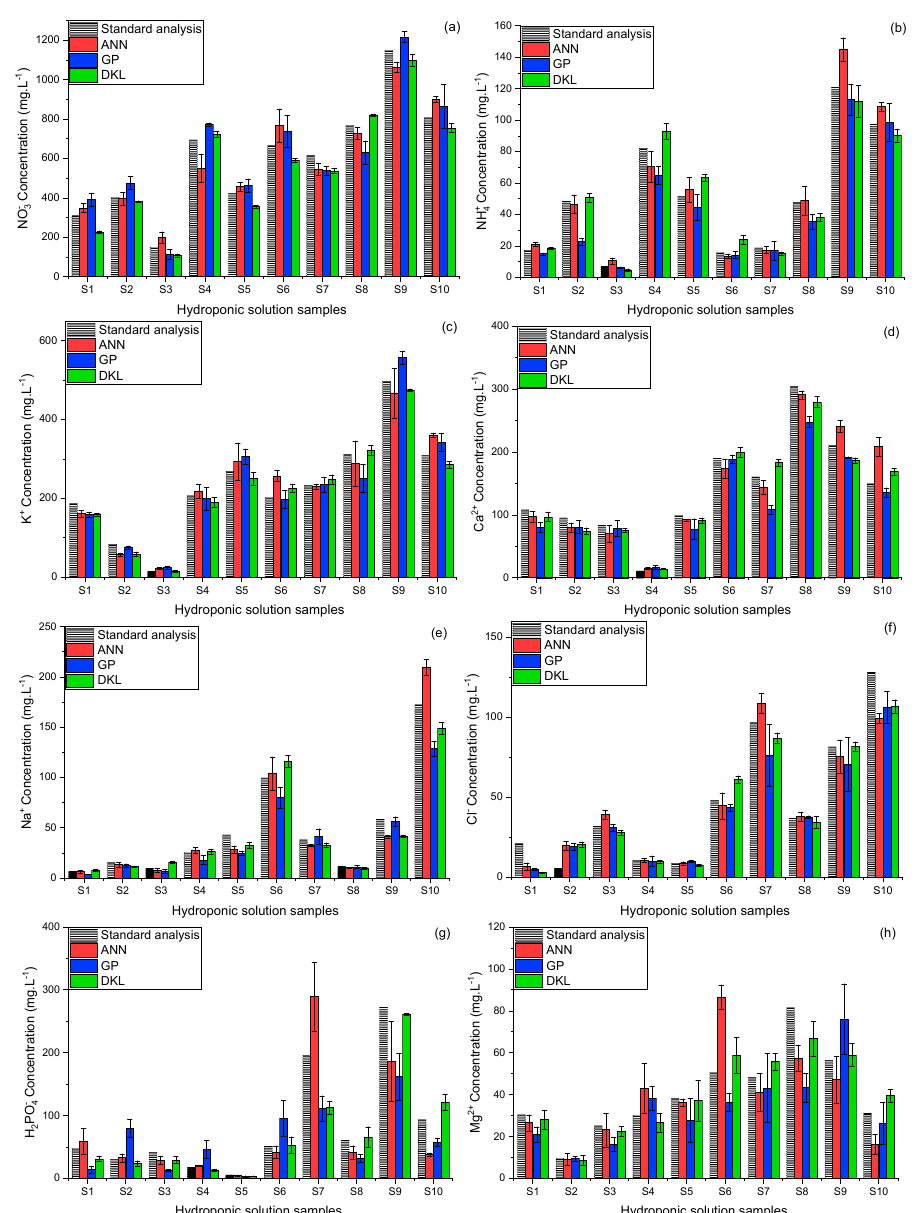
Figure 7. Comparison of the actual concentrations with the predicted concentrations determined by proposed models using ten different hydroponic samples ( a ) 𝑁𝑂 (cid:2871)(cid:2879) , ( b ) 𝑁𝐻 (cid:2872)(cid:2878) , ( c ) 𝐾 (cid:2878) , ( d ) 𝐶𝑎 (cid:2870)(cid:2878) , ( e ) 𝑁𝑎 (cid:2878) , ( f ) 𝐶𝑙 (cid:2879) , ( g ) 𝐻 (cid:2870) 𝑃𝑂 (cid:2872)(cid:2879) , and ( h ) 𝑀𝑔 (cid:2870)(cid:2878) . Error bars indicate standard deviations of three replicates.